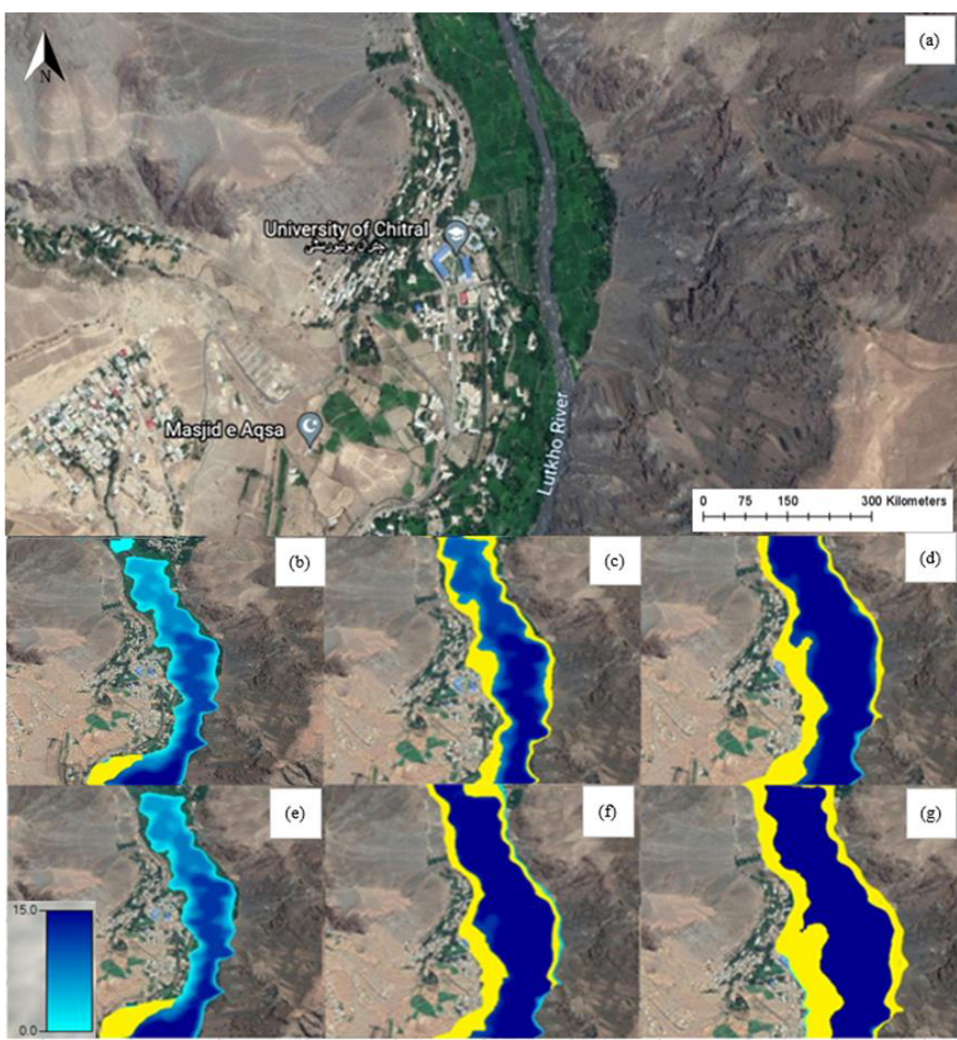
Figure 5. ( a ) Chitral river reach showing the study area before mapping. Flood mapping of Chitral river under ( b ) mid-century 2.6, ( c ) mid-century 4.5, ( d ) mid-century 8.5, and ( e ) late-century 2.6, ( f ) late-century 4.5, ( g ) late-century 8.5, RCP scenarios. The yellow color in the Figures represents the regions/settlements affected by the flood.